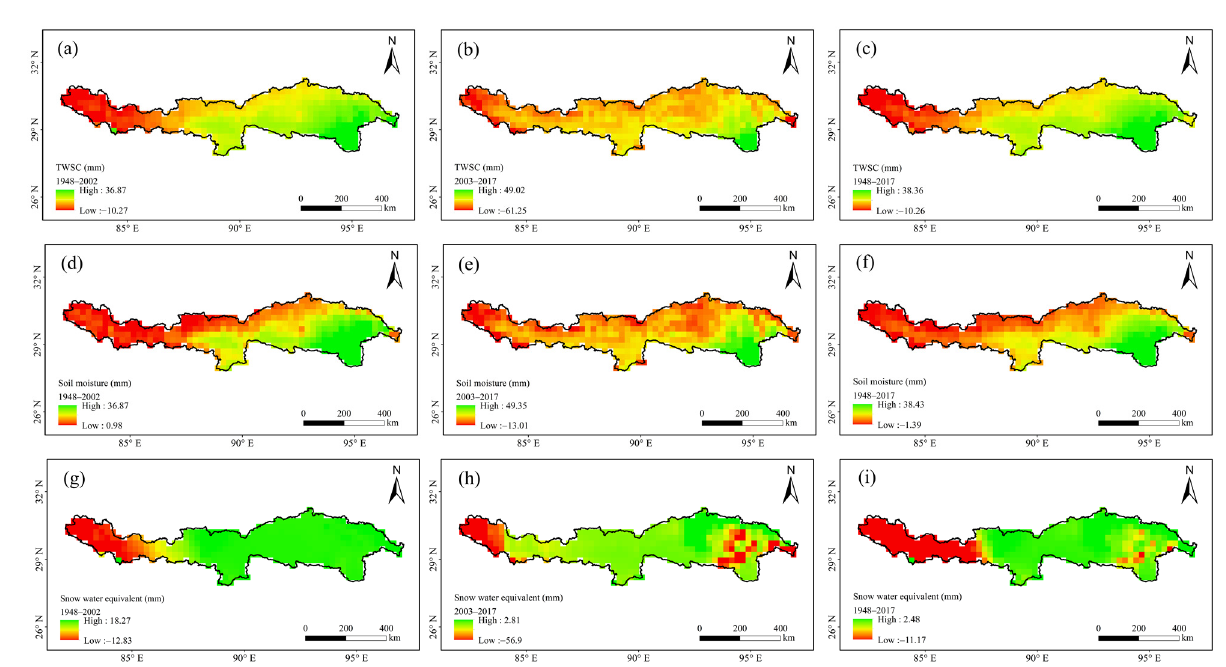
Figure 12. Spatial distribution of TWSC ( a – c ), soil moisture ( d – f ), and snow water equivalent ( g – i ) from 1948 to 2017.